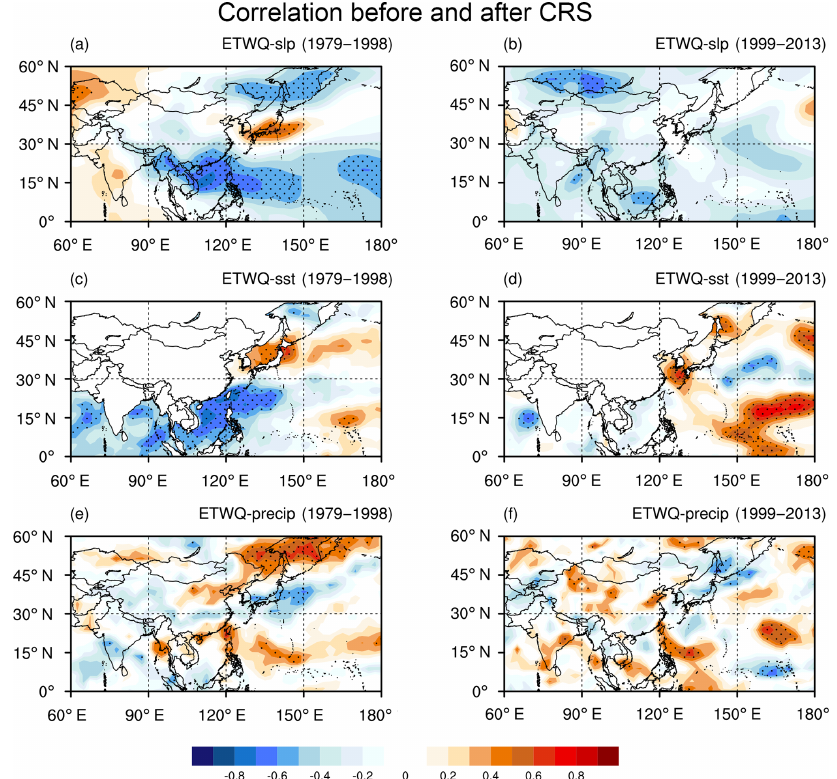
Figure 7. Correlation maps of the eastern Taiwan runoff (ETWQ) before (a, c, e) and after (b, d, f) the year 1999. The top, centre, and bottom panels are ETWQ vs. SLP, ETWQ vs. ERSST, and ETWQ vs. GPCP data, respectively. Correlation values at a 5% significance level are